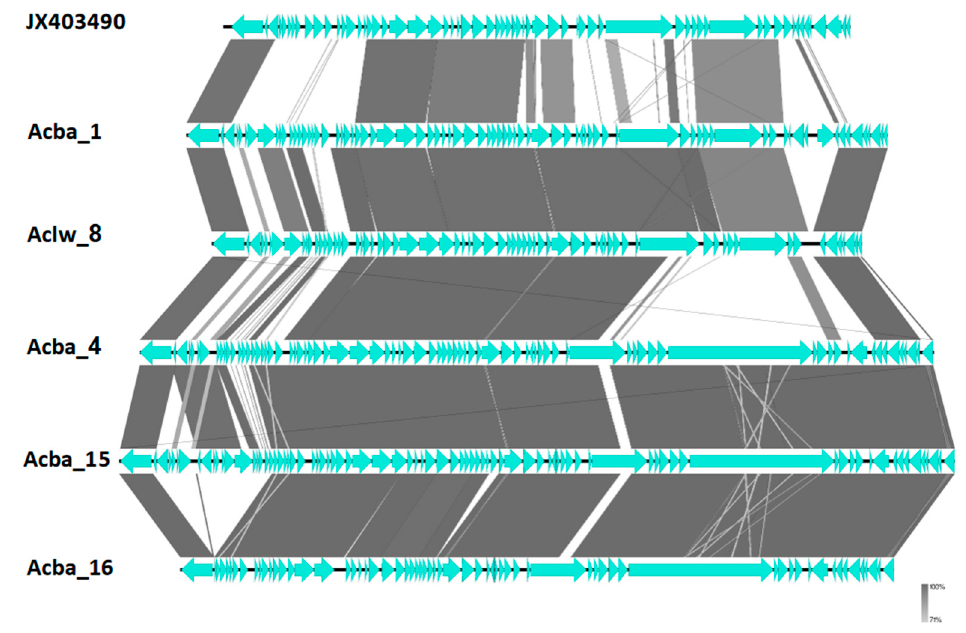
Figure 5. Comparison of genomes between researched phages and the reference phage for Vieuvirus genus. Genomes were compared using blastn and represented by the Easyfig software. The genome of the representative phage is on the top. Horizontal black lines (genome) with blue arrows (ORFs) represent phage genomes. Gray, thick, vertical lines represent similar fragments of genomes between phages. Thin gray or white lines represent similarity between short, internal repeats found in compared genomes.